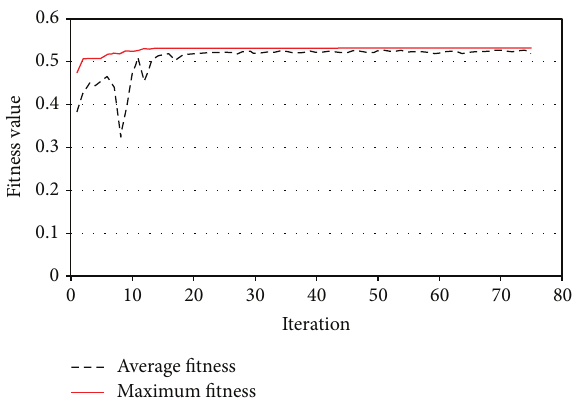
Figure 13: Fitness values versus iterations in example problem 1.